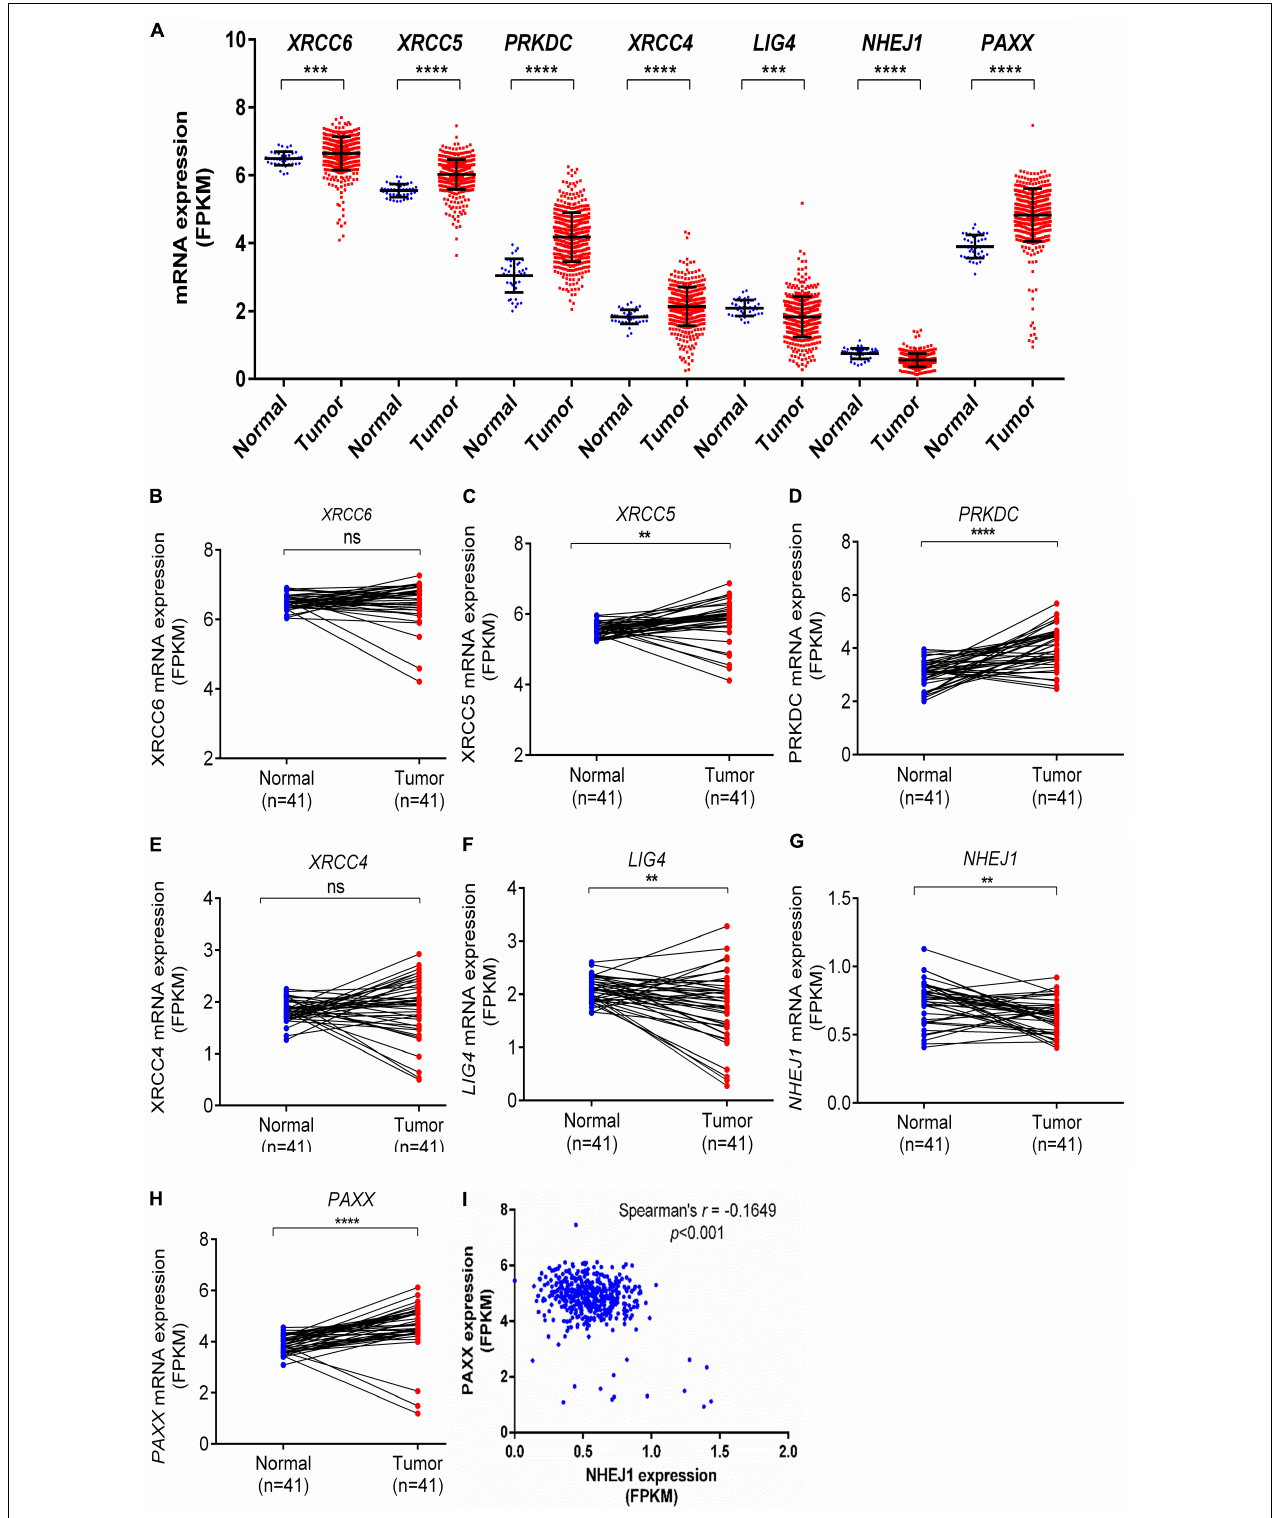
FIGURE 1 | Comparison of mRNA expression of NHEJ pathway genes in normal colon and colon cancer tissues from TCGA-COAD dataset including total samples for seven NHEJ genes (A) , and paired samples, including XRCC6 (B) , XRCC5 (C) , PRKDC (D) , XRCC4 (E) , LIG4 (F) , NHEJ1 (G) , and PAXX (H) . * p < 0.05, ** p < 0.01, *** p < 0.001, **** p < 0.0001. (I) Correlation between NHEJ1 and PAXX expression in the same dataset. FPKM, Fragments per kilo million